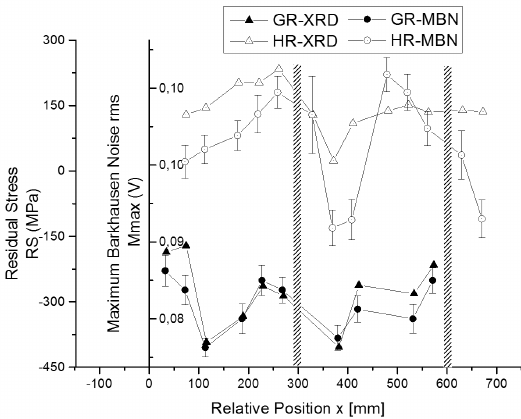
Figure 6. Comparison between XRD residual stress values measured along the longitudinal (“x”) direction and the amplitude of the RMS of the Barkhausen noise signal.